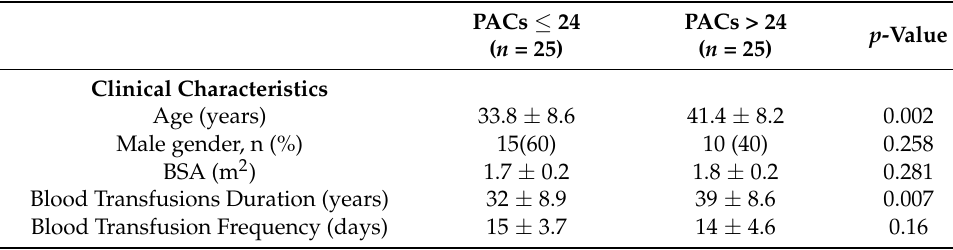
Table 1. Clinical, biochemical and 24-hour Holter parameters in β -thalassemia-major patients with premature atrial contractions ≤ 24/day and >